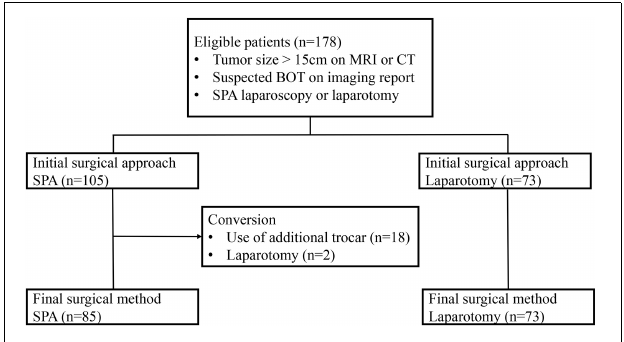
FIGURE 1 | Flow chart for the studied